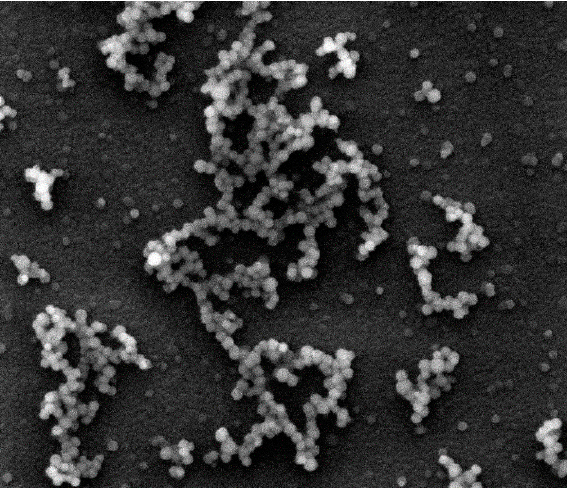
Figure 4. A scanning electronic microscopy image of a silicon dioxide sample illustrating the process of diffusion-limited aggregation that proceeds simultaneously with the cluster-cluster aggregation (image size 40 μ m х 40 μ m).